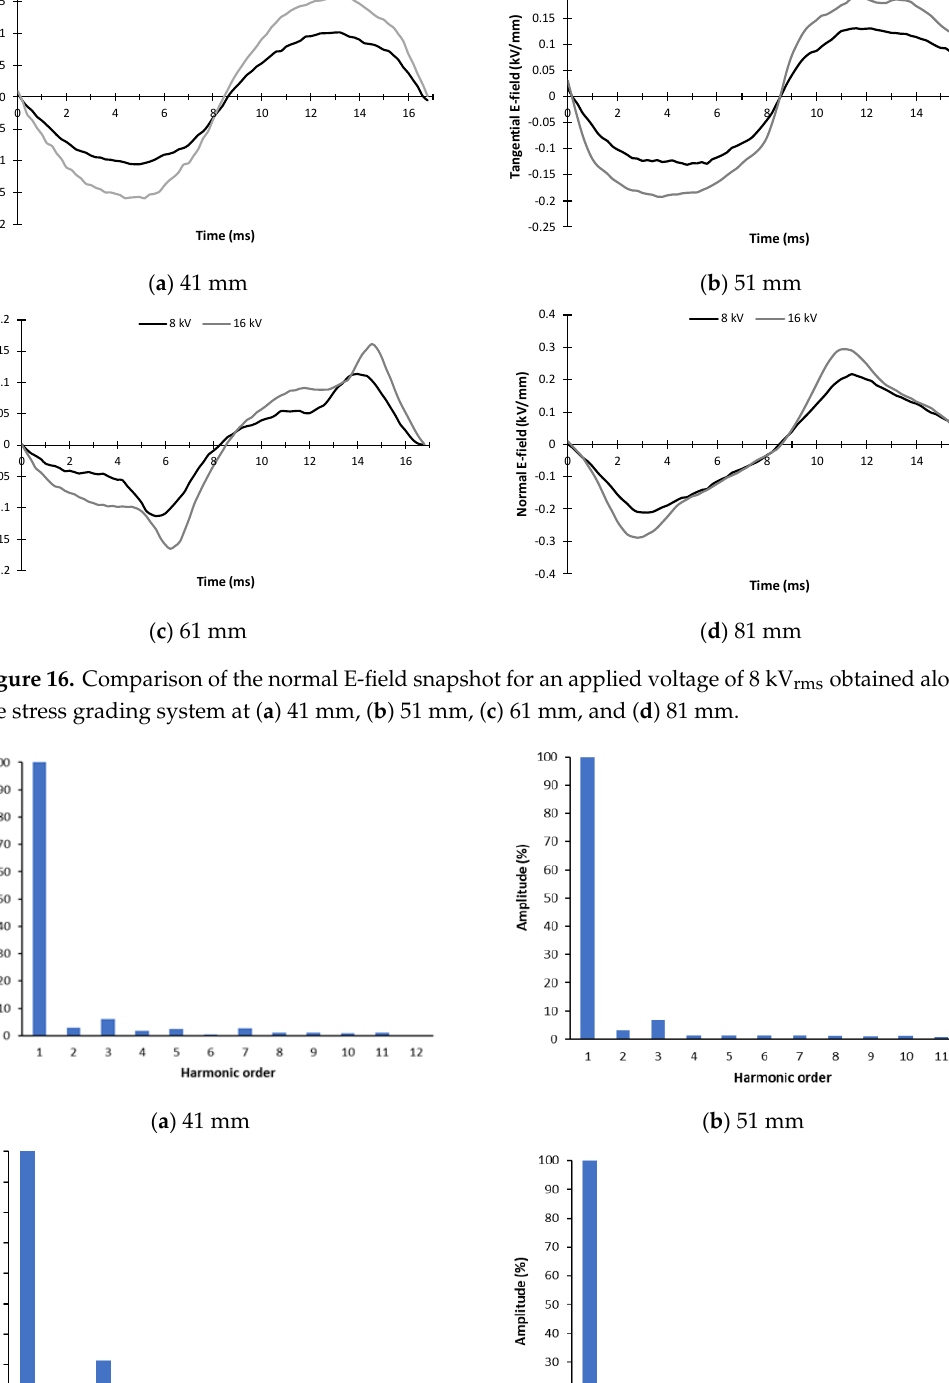
obtained along the stress grading system at ( a ) 41 mm, ( b ) 51 mm, ( c ) 61 mm, and ( d ) 81 mm.